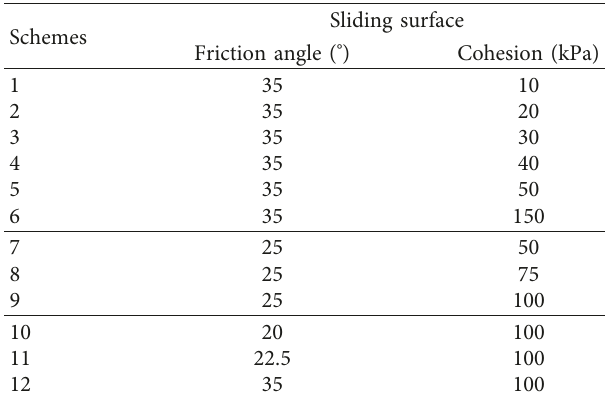
Table 5: Plastic parameters of the sliding surface and numerical test